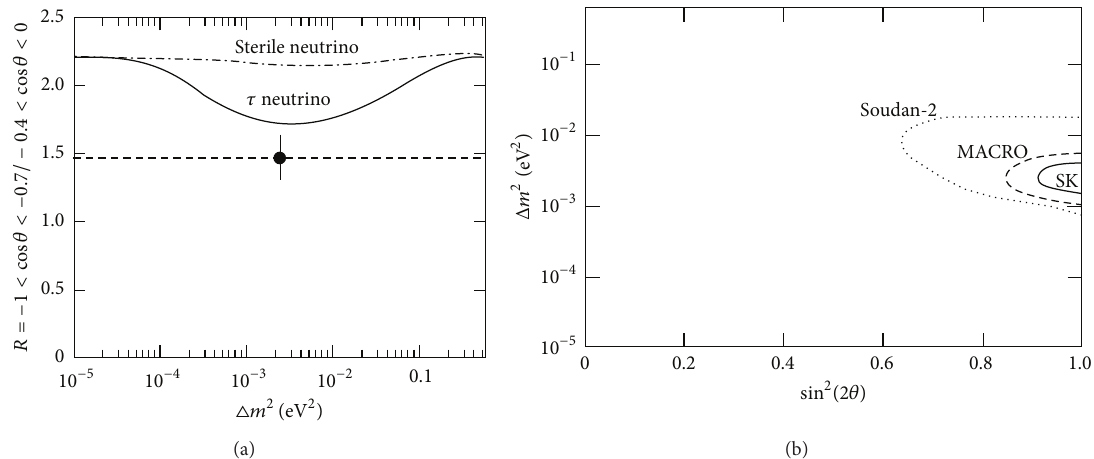
Figure 6: (a) The MACRO ratio between the data in two angular bins (black point on gray line) and comparison with MC ] 𝜇 ↔ ] oscillations. (b) 90% CL allowed regions for the ] 𝜇 ↔ ] 𝜏 oscillations up to year 2004.